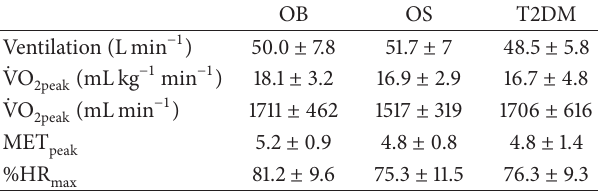
Table 2: Absolute and relative exercise intensities at maximal effort in obese, sarcopenic obese, and T2DM